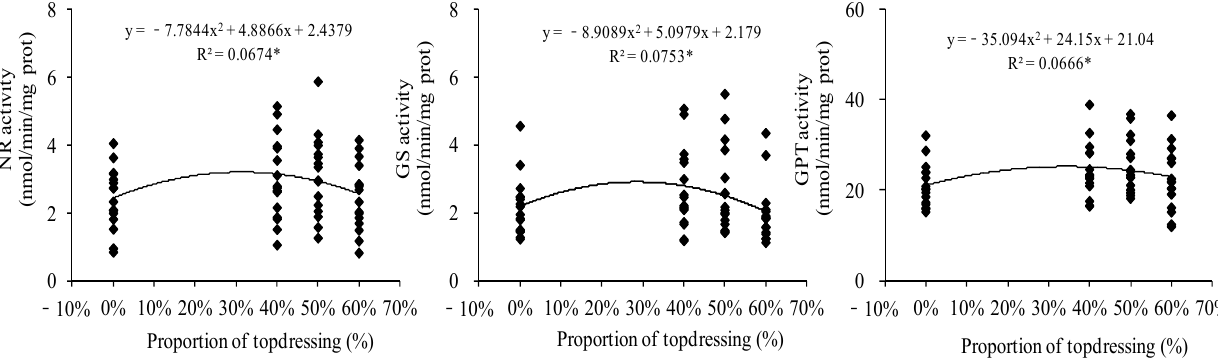
Figure 10. Relationships between fertilization and key enzyme activity. Note: “*” indicate a significant correlation at the 0.05 probability level. The dots represent the measured values, and the lines represent the correlation trend in the figure.